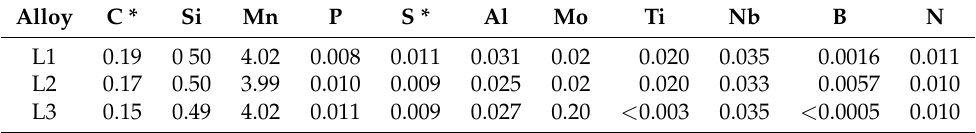
Table 1. Chemical composition of the laboratory melts. All concentrations are given in wt.%.